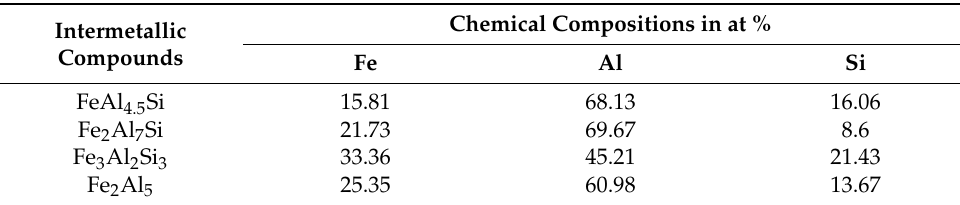
Table 3. EDS results of intermetallic compounds in the Al–Si coating layers through different heat treatment